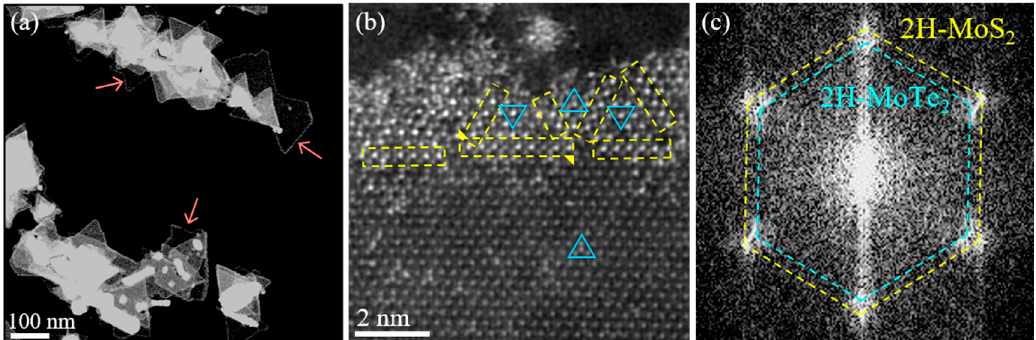
Figure 1. ( a ) A low-mag annular dark-field scanning transition electron microscope (ADF-STEM) image showing the morphology of the tellurized MoS 2 sample. All the edge areas (arrowed in pink) appear brighter than their interior parts. ( b ) A magnified ADF-STEM image showing the atomic structure of a typical edge area after Te doping. The 4 | 4P-Te mirror twin boundaries (MTBs) are mapped out in the yellow dashed rectangles. ( c ) An image of the corresponding fast Fourier transformation spectrum (FFT) of ( b ), where the first-order di ff raction spectra of 2H-MoTe 2 and 2H-MoS 2 are marked with blue and yellow dashed lines, respectively.